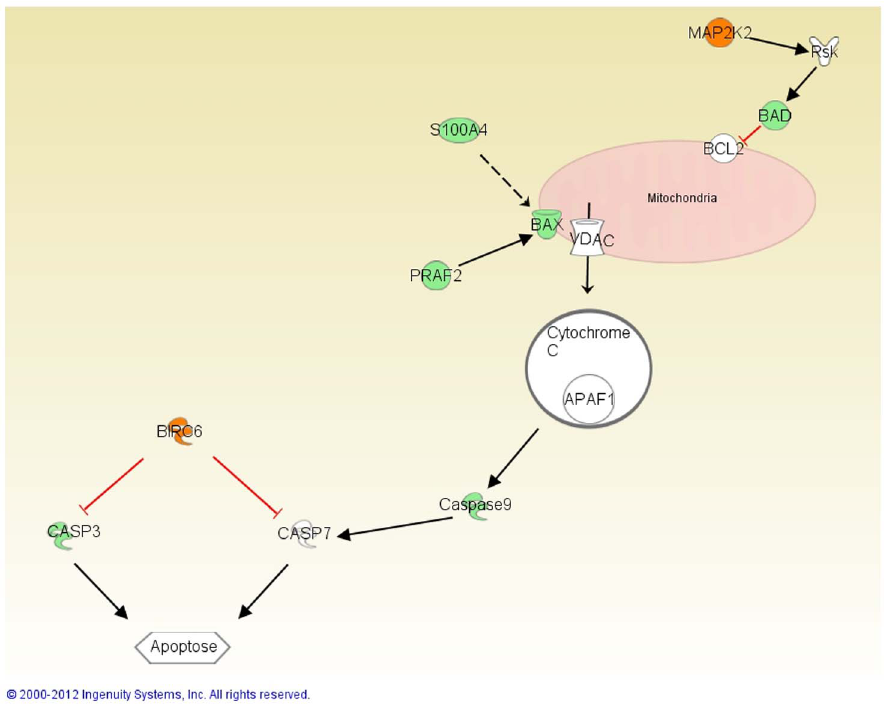
Figure 4. Overview of changed proteins of the mitochondrial apoptosis pathway. This pathway was performed with IPA. The red colored proteins demonstrate that the protein is up-regulated and the green colored that they are down-regulated. Red arrows represent a direct inhibitory function and the black arrows direct activation function. The dotted arrow represents indirect interaction via transcriptional regulation.